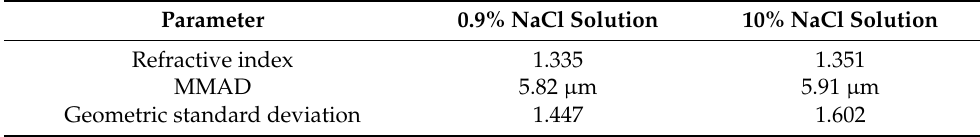
Figure 2. HL100A vibrating mesh nebulizer: ( a ) front view without mouthpiece, ( b ) side view with mouthpiece. Table 1. Droplet size distributions of nebulized 0.9% and 10% w/v NaCl solutions.